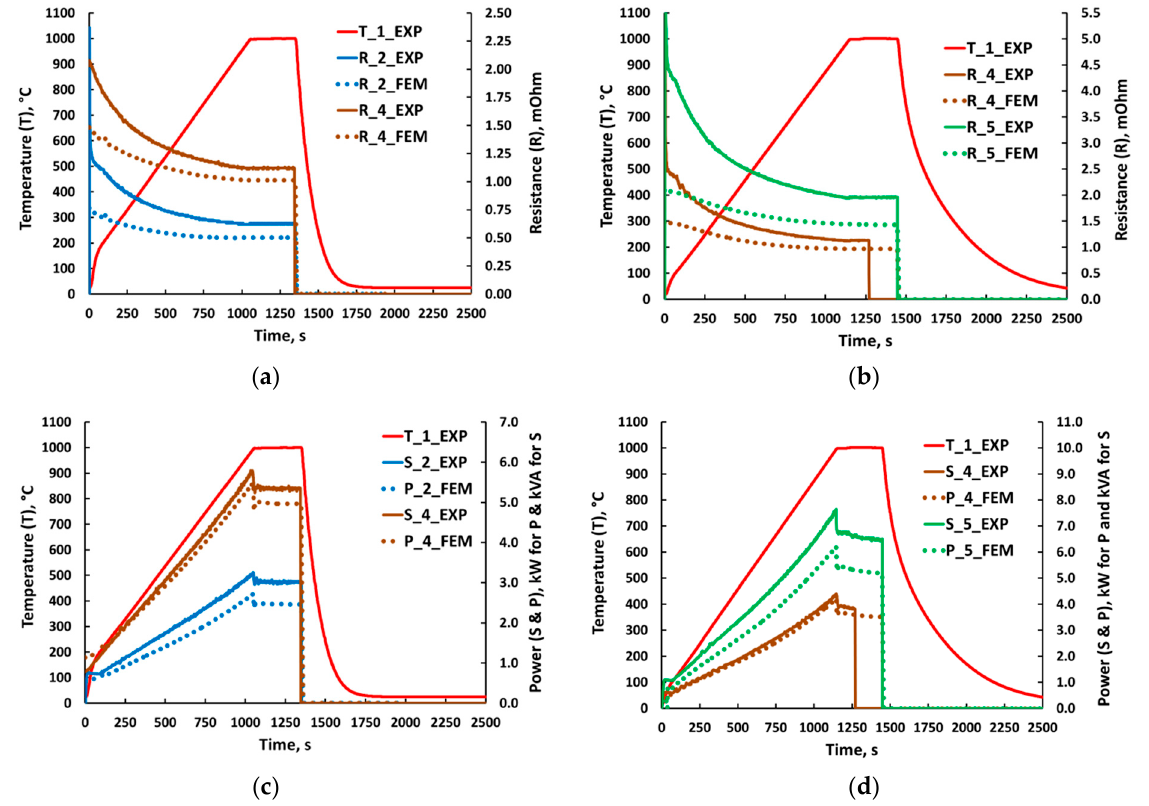
Figure 10. Resistance ( a,b ) and power dissipation ( c,d ) between two symmetrically located probes. Left—regular setup, right—setup with CFRC plates. Solid lines are data calculated from experimental values of voltage and current. Dotted lines are results from FEM modeling.